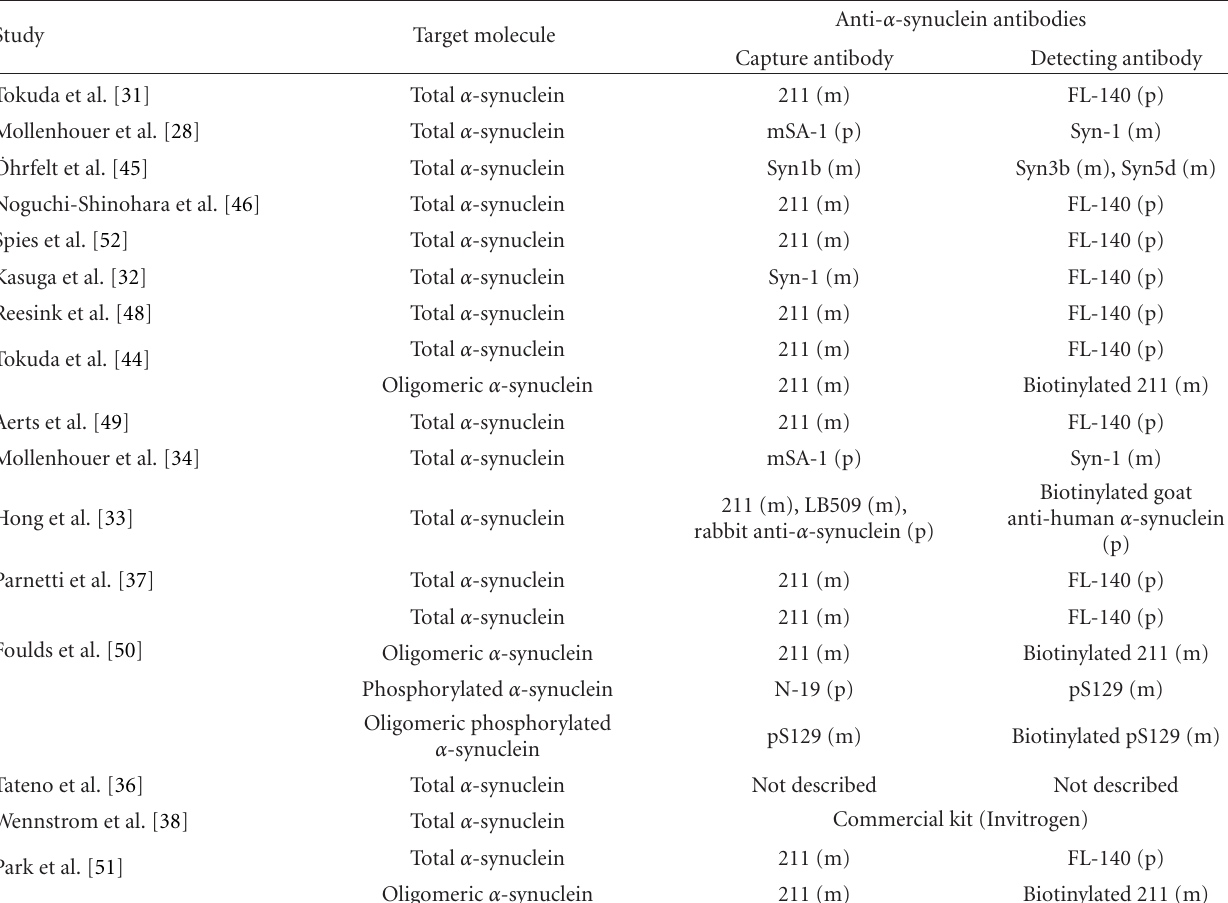
Table 2: Summary of antibodies used to quantify α -synuclein in